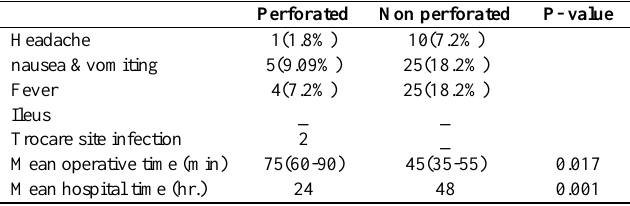
Table 2: Clinical Outcomes and Postoperative Complications.